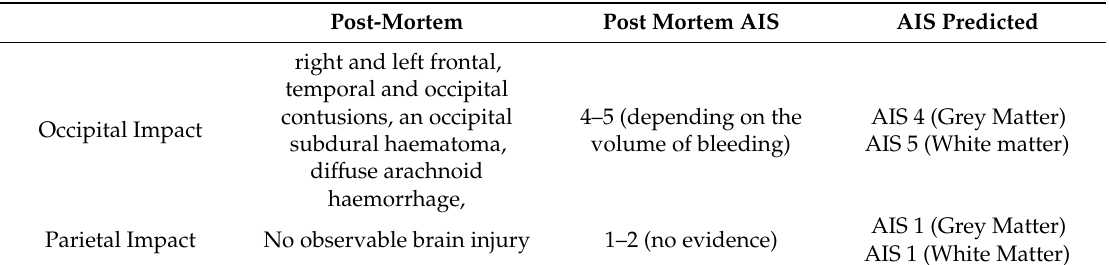
Table 6. Summary of results (comparison with post-mortem).